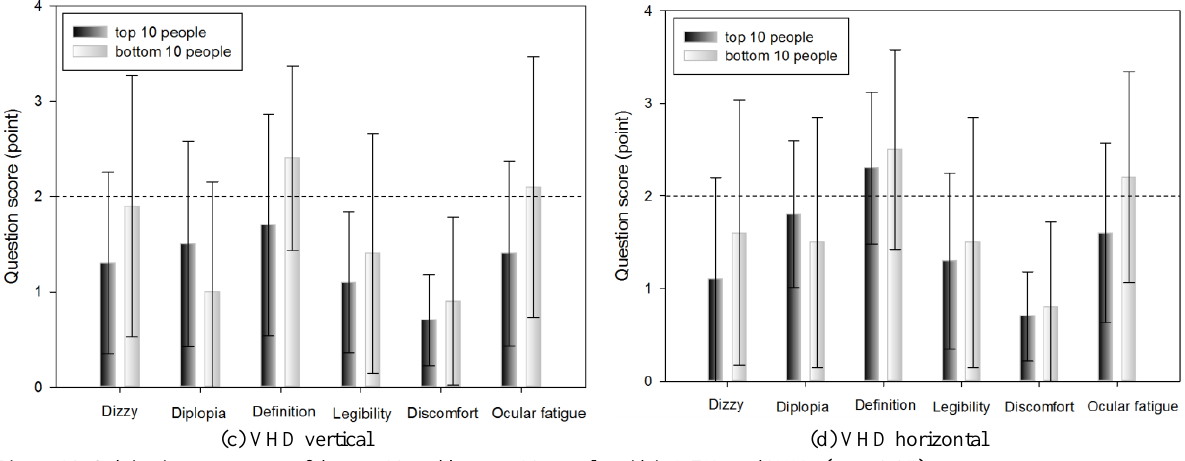
Figure 12. Subjective symptoms of the top 10 and bottom 10 people within DEM and VHD (*: p<0.05)